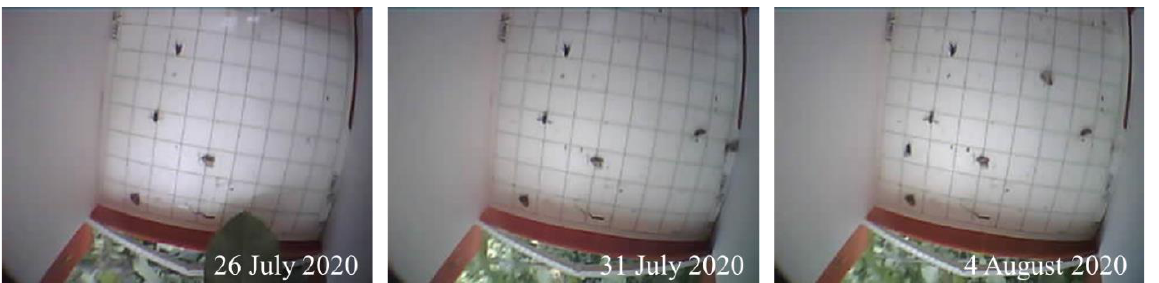
Figure 4. Imaging system plug-in retrofitted in a delta trap installed in apple canopy.